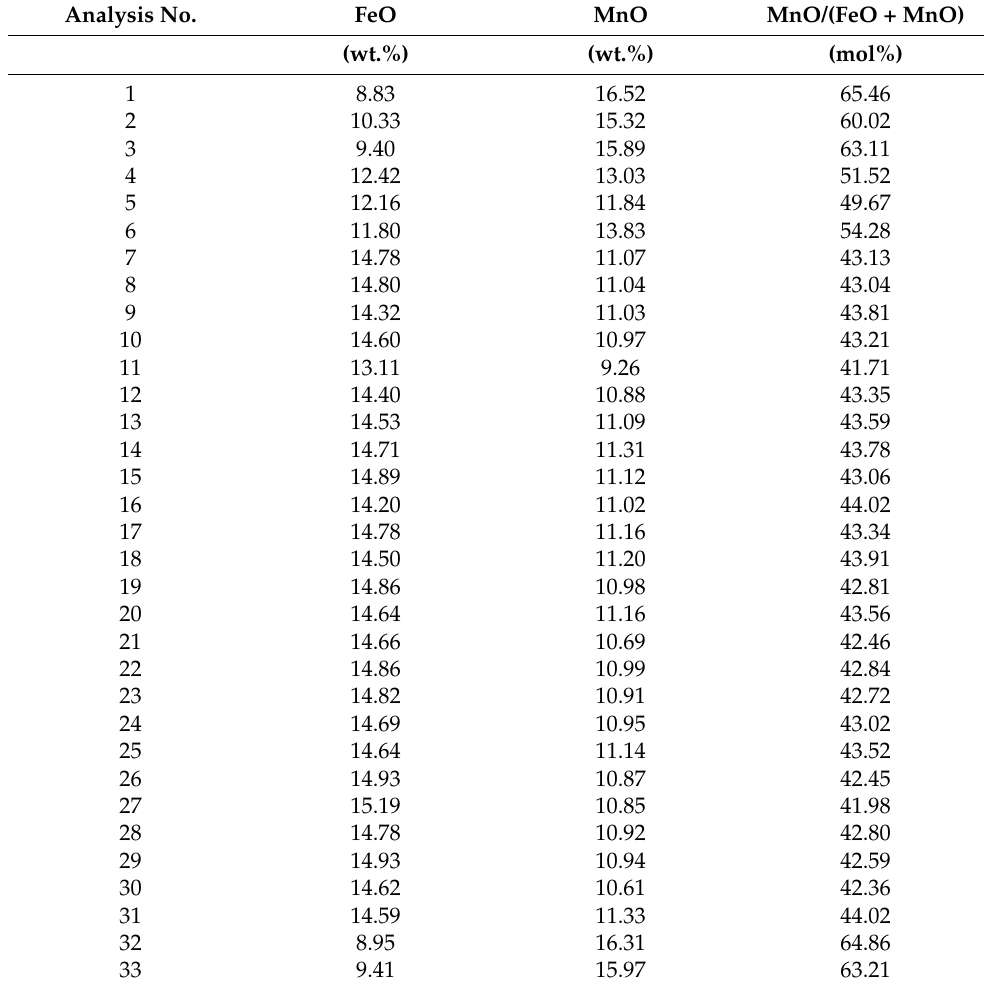
Table 3. Quantitative EPMA analyses of a wolframite grain (82032404; Table 1) from No. 7 vein at − 4L (57 m above sea level, Figure 4) for FeO and MnO. Analysis No. FeO MnO MnO/(FeO + MnO) (wt.%)